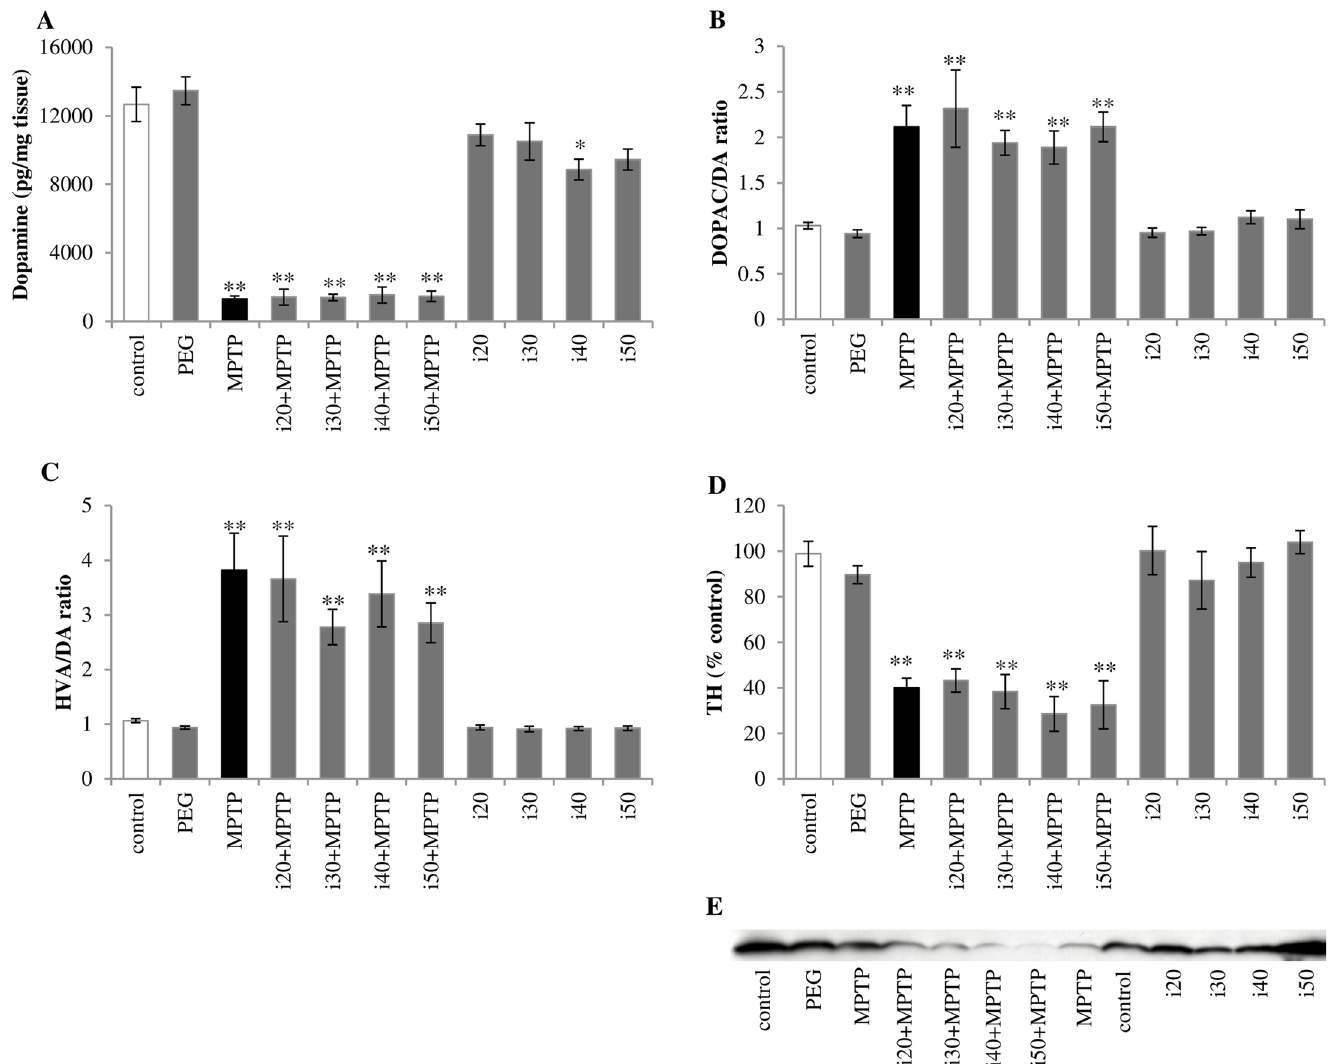
Fig 1. Effect of IBD on the injured nigrostriatal systemseven days after MPTP intoxication. (A) DA concentration in the striata of C57Bl/10Tar mice, measuredby HPLC. (B) The ratio of DOPAC to DA and (C) the ratio of final DA metabolite(HVA) to DA indicate the DA turnover rate. (D) Expression of tyrosine hydroxylase(TH) (the rate-limitingenzyme in catecholamine synthesis) in mice striatum was evaluatedby Western blot analysis, and (E) one representative blot is shown of five independent experiments. Abbreviations of groups of animals: control–saline-treated; PEG–vehicle-treated; MPTP– MPTP-intoxicated; i(20, 30, 40, or 50)+MPTP–IBD [20, 30, 40, or 50 mg/kg] and MPTP-treated; i(20, 30, 40, or 50)–IBD [20, 30, 40, or 50 mg/kg] treated. The data are shown as means ± SEM (n = 5–6) ( * representsa significantdifference relativeto the control group, * p < 0.05, ** p < 0.01;Mann Whitney U